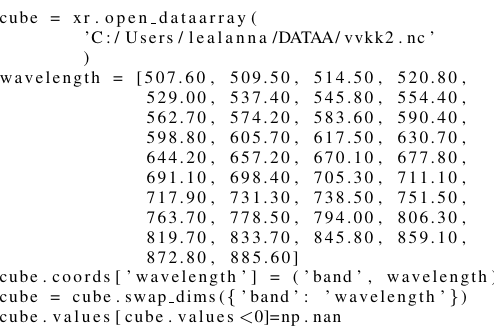
Figure 4. Here we use xarray’s sel-method to extract the data we